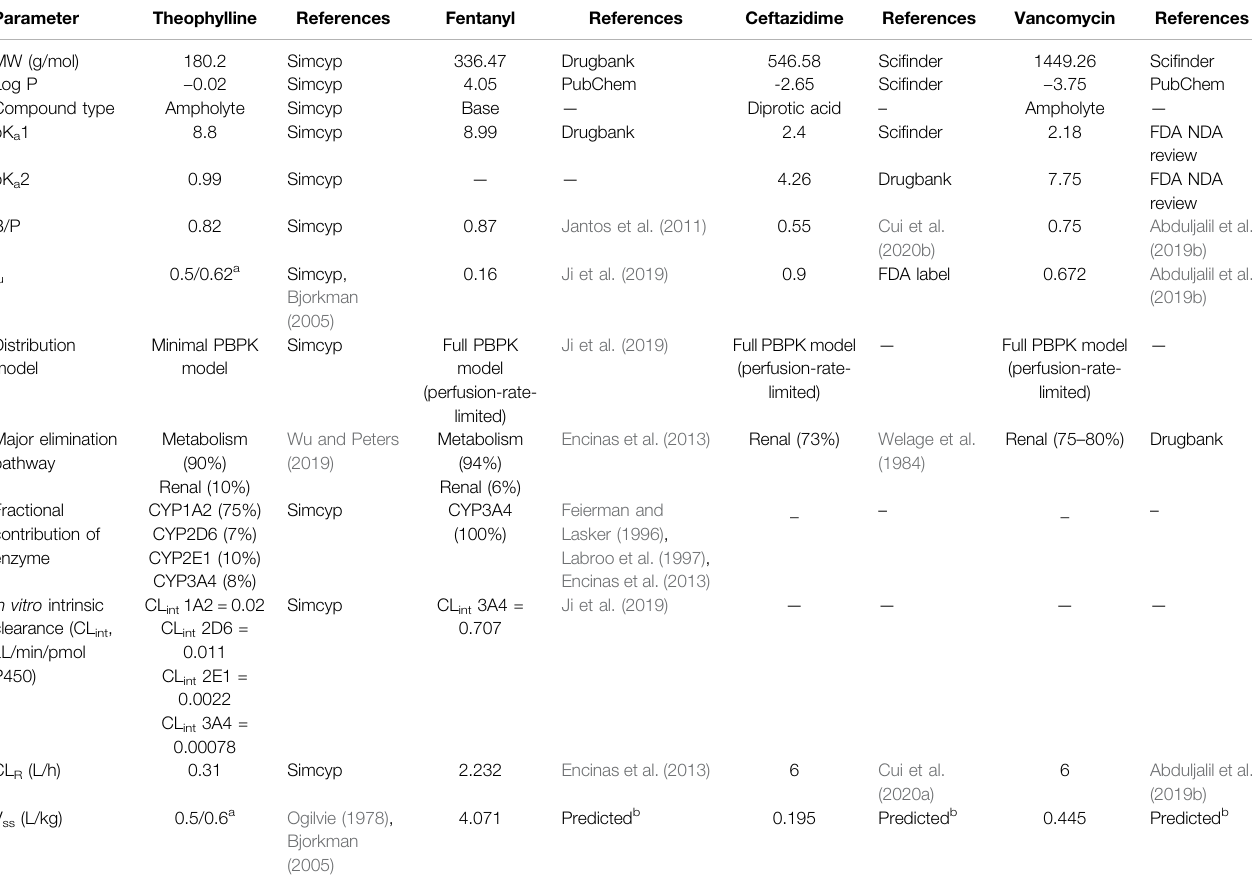
TABLE 1 | Summary of PBPK model parameters of probe drugs.